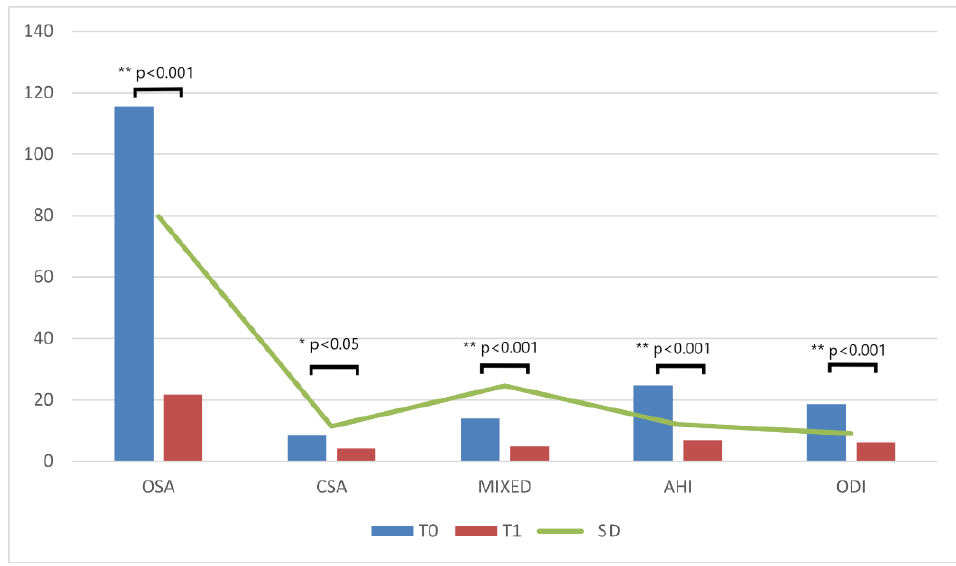
Figure 2. Descriptive statistics and statistical comparison of PSG parameters before (TO) and after (T1) treatment, standard deviation (SD) of the mean value of the difference between T1 and T0 for all the parameters (* p < 0.05; ** p < 0.01).